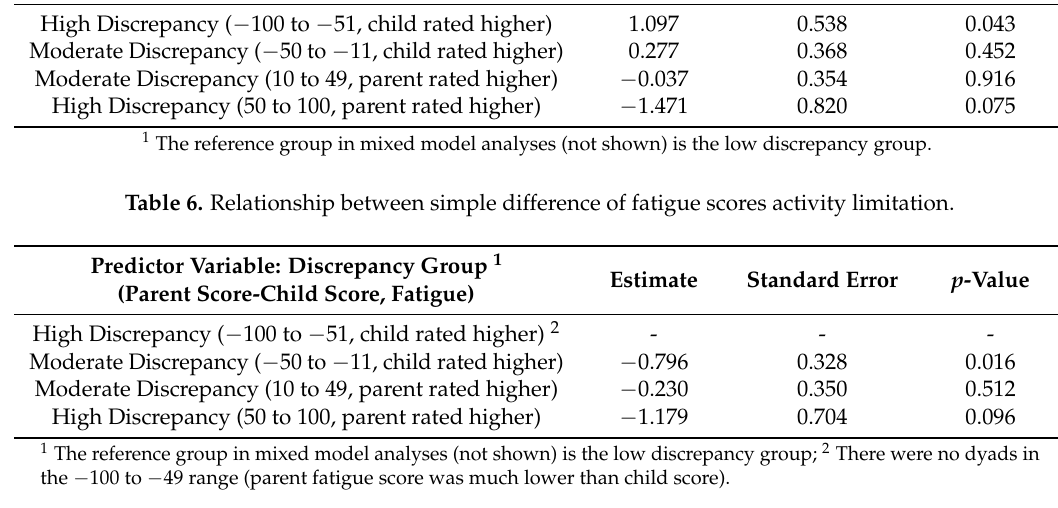
Table 5. Relationship between simple difference of pain scores and activity limitation. Predictor Variable: Discrepancy Group 1 (Parent Score-Child Score, Pain)